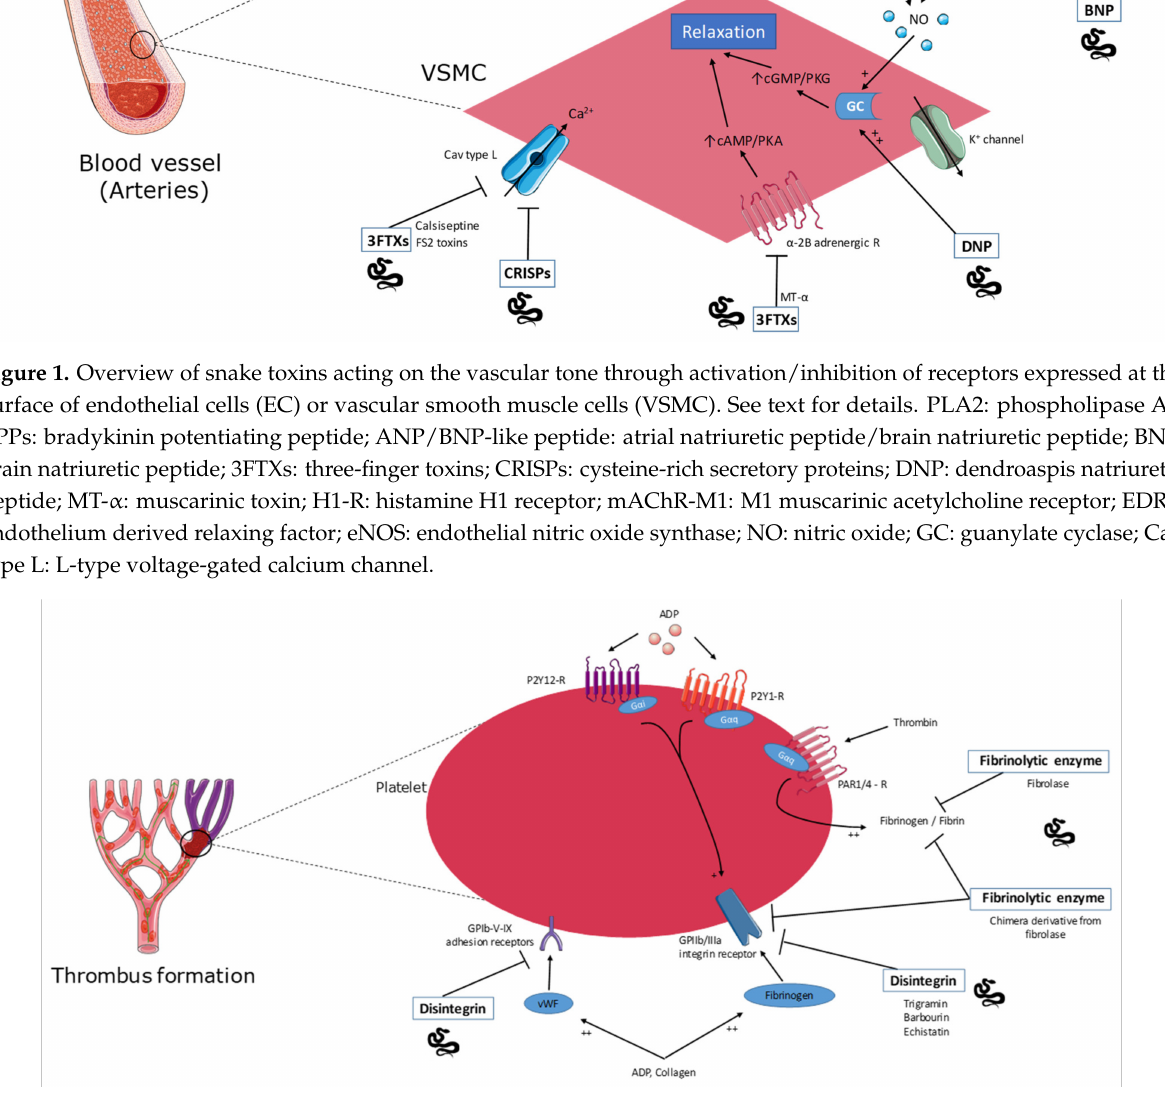
Figure 2. Overview of the molecular targets of snake venom toxins with antithrombotic effect. See text for details. Disintegrins and fibrinolytic enzymes, two different families of proteins, act on the surface of platelets via different receptors and glycoproteins or directly by digesting fibrin to inhibit thrombus formation. ADP: adenosine diphosphate; vWF: von Willebrand factor; GPIIb/IIIa ( α IIb β 3): platelet-specific integrin receptor; GPIb-V-IX: platelet glycoprotein adhesion receptor; P2Y12-R, P2Y1-R: ¨ Platelet G-protein-coupled receptor for ADP; PAR1/4-R: Protease activated receptors as G-protein-coupled receptors for